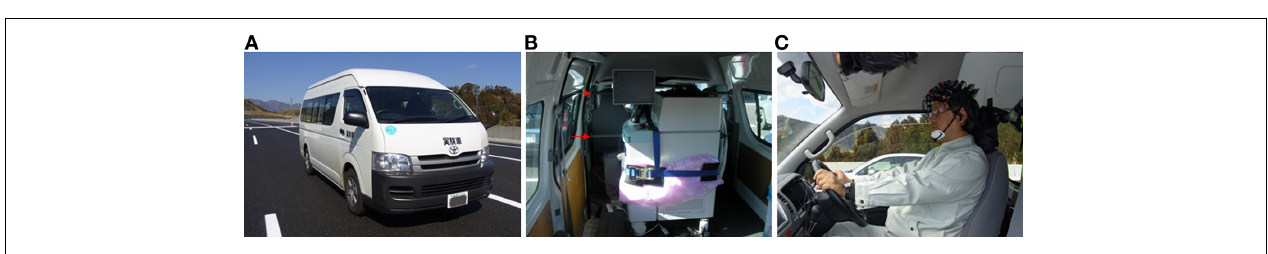
FIGURE 3 | The experimental vehicle and the fNIRS apparatus. (A) The experimental vehicle. (B) fNIRS equipment mounted in the vehicle. The equipment was secured to two bars attached to the vehicle, indicated by red